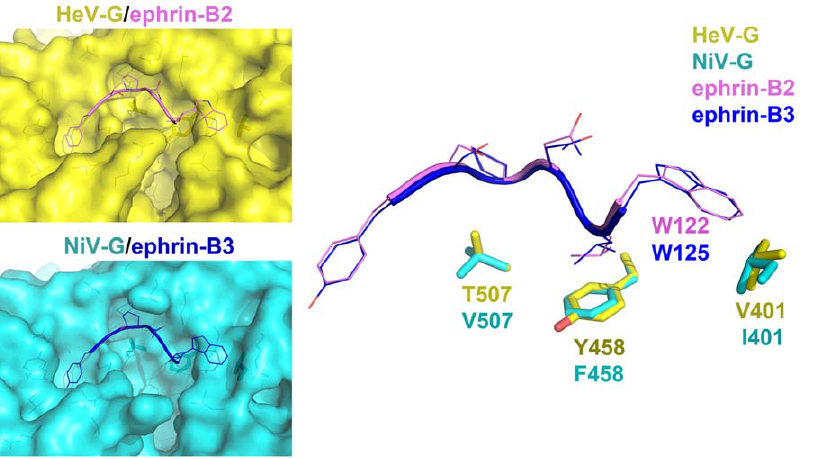
Figure 4. Comparison of the NiV-G/ephrin-B3 and HeV-G/ephrin-B2 interfaces. HeV-G residues are colored in yellow; NiV-G is in cyan. The changes V/T507, F/Y458, I/V401 alter the hydrophobicity of the interface and thus contribute to the different receptor-binding affinities of NiV-G and HeV-G.